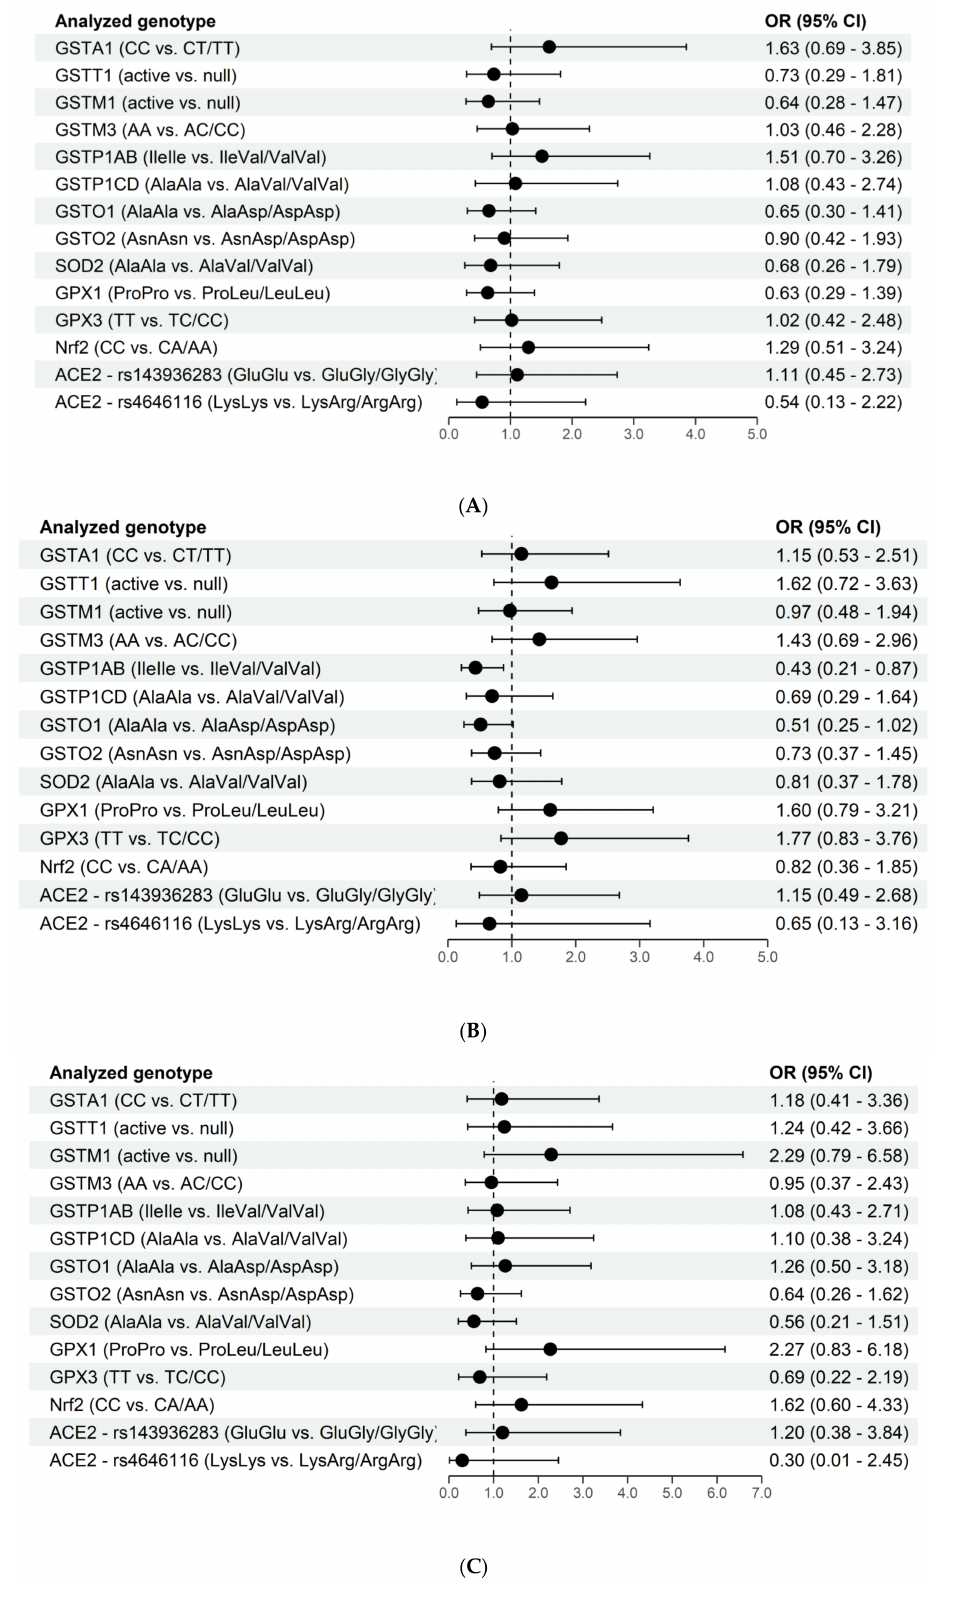
Figure 2. ( A ). The association of genetic variations and long-COVID fatigue. ( B ) The association of genetic variations and long-COVID myalgia. ( C ). The association of genetic variations and long- COVID “brain